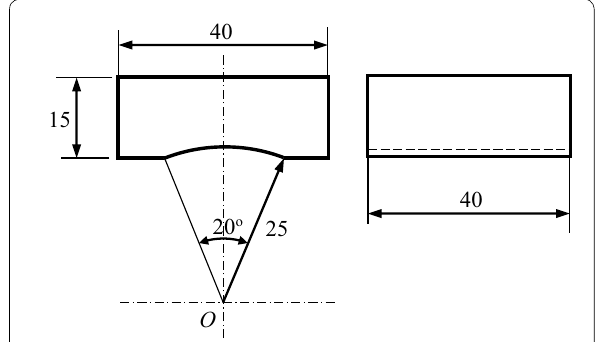
Fig. 3 Shape and dimensions of dynamic splitting test pad.